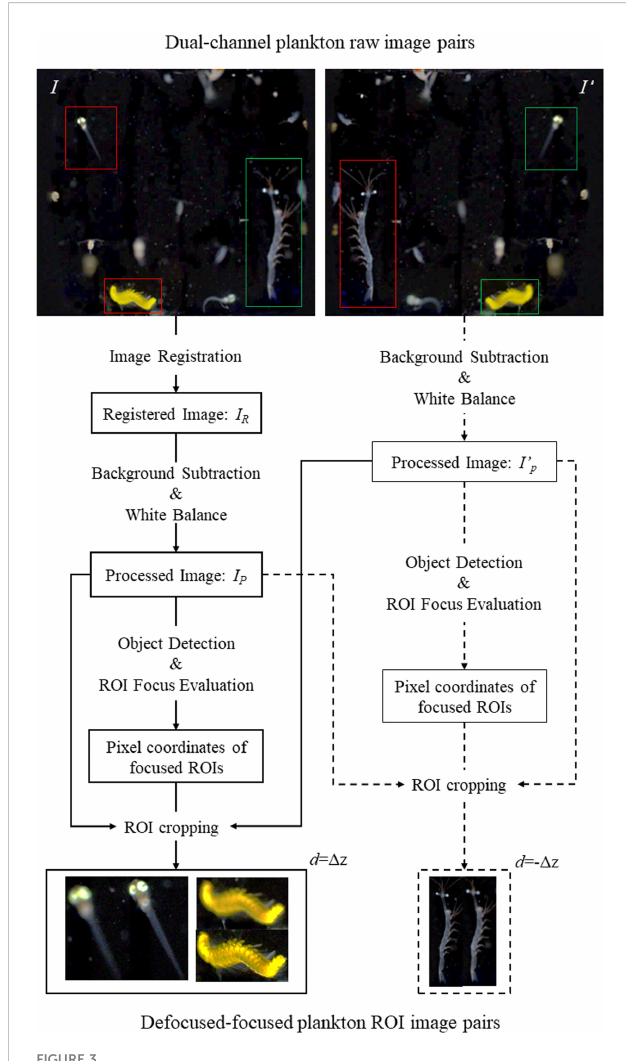
FIGURE 3 Flow chart of generating defocused-focused plankton ROI pairs from processing a pair of dual-channel raw plankton images. Red and green frames represent focused and defocused plankton ROIs,